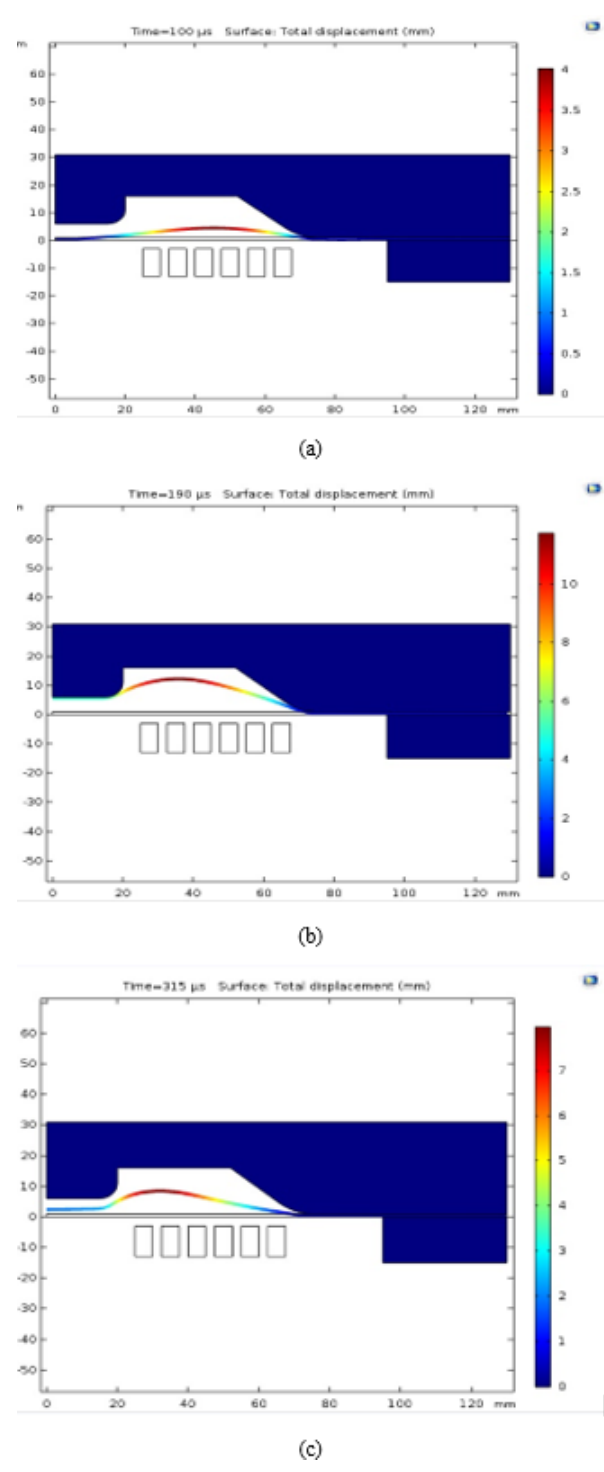
Figure 11. Total displacement at various time steps: (a) time step 100µs (voltage = 2400, sheet = 1.02mm, N = 6), (b) time step 190µs (voltage = 2400, sheet = 1.02mm, N = 6), (c) time step 315µs (voltage = 2400, sheet = 1.02mm, N =